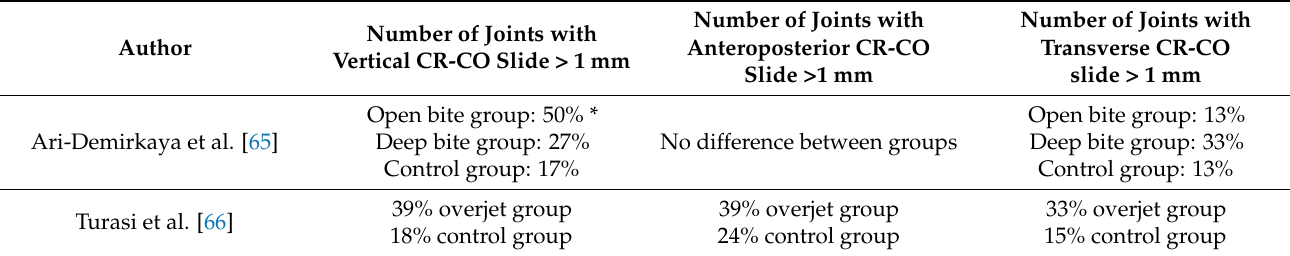
Table 6. Number of condyles with displacement > 1